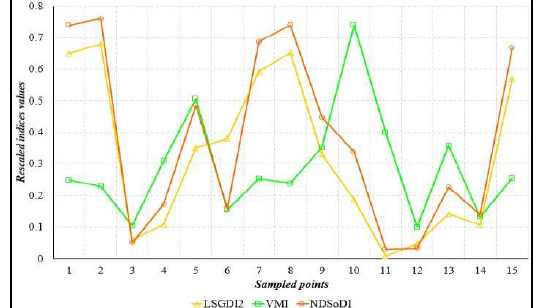
Figure13. LSGDI2, NDSoDI and VMI for April